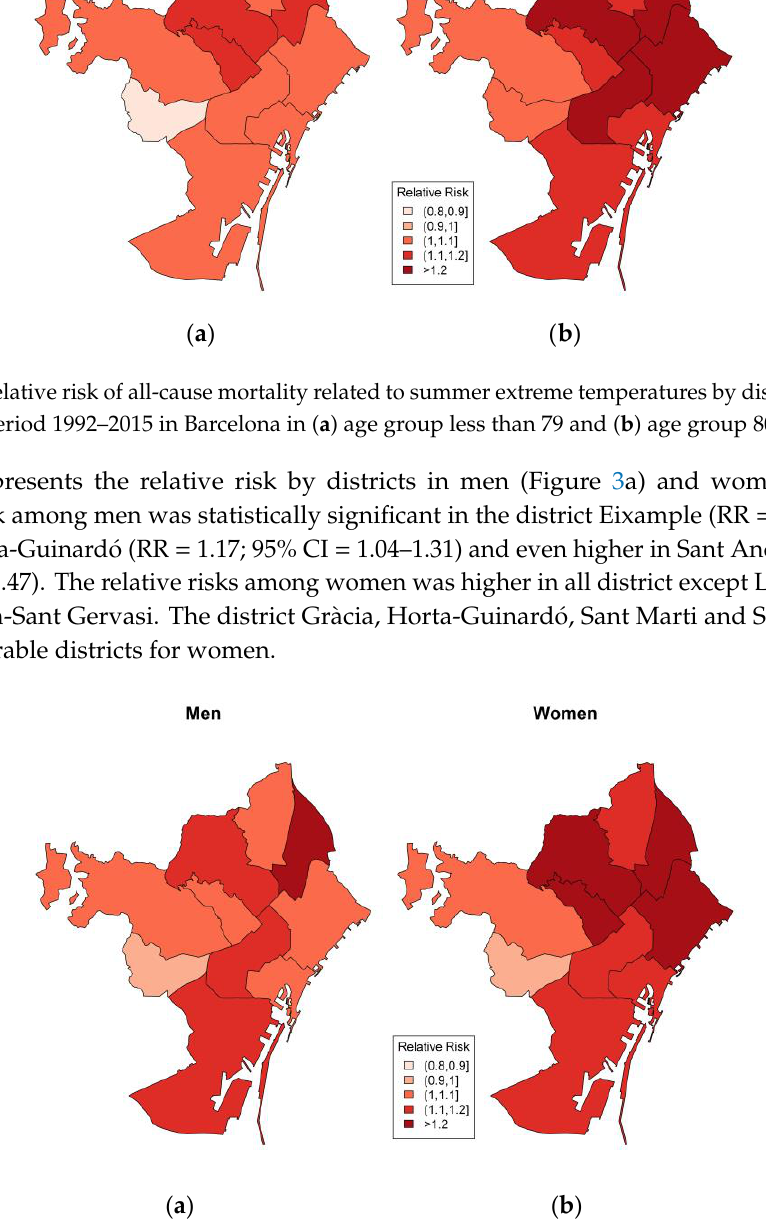
( b ) Figure 1. ( a ) Map of summer mean (1 June–30 September) temperature in (˚C) and ( b ) relative risk map of all-cause mortality related to summer extreme temperatures by district during the study period 1992–2015 in Barcelona. 3.3. The Spatial Distribution of Heat-Related Mortality Results Stratified by Age, Sex and Education The results for districts stratified by age, sex and education are presented in the Supplementary Material (Tables S1, S2 and S3). In Figure 2, the relative risk maps by district shows non-significant